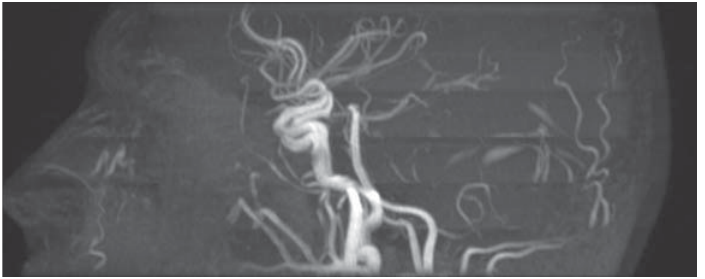
FIGURE 2. Intact vessels on fl uorescein